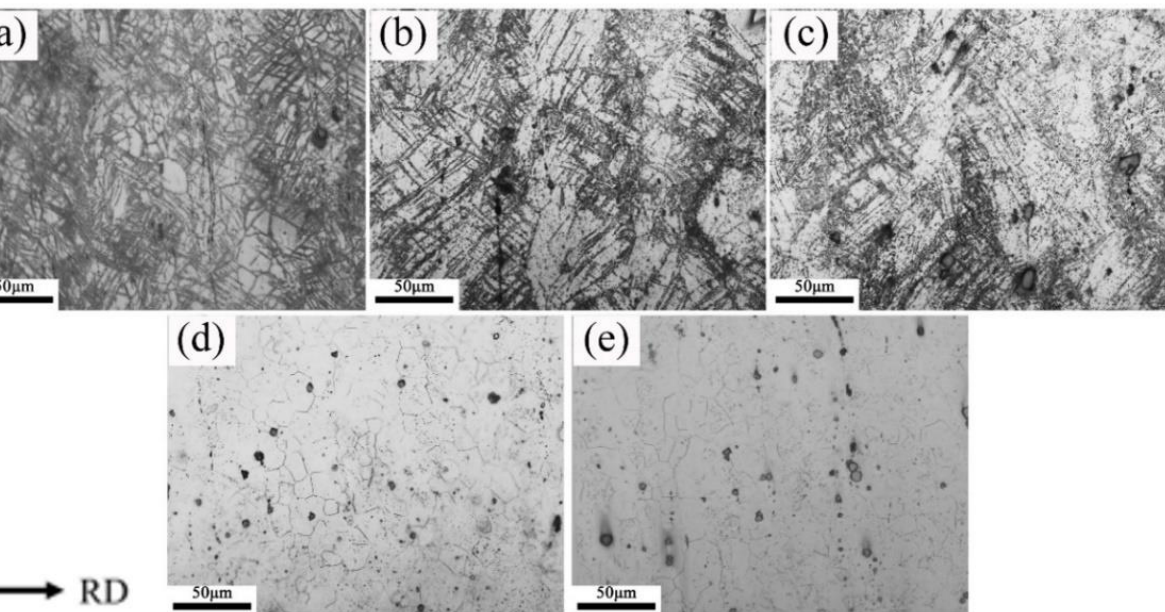
The OM metallographic images of the AZ61-modified rolled sheets are shown in Figure 2. For the AZY0, AZY1 and AZY2 sheets, the deformation grains dominated, which were arranged at an angle of 45 ◦ to the deformation direction (Figure 2a–c). Among them, the AZY0 grains were relatively fine (Figure 2a), and with the increase in Y content, the size of the grains further decreased (Figure 2b,c). When the content of Y was further increased above 0.9 wt.%, there were no longer deformation grains in the AZY3 and AZY4 sheets, but the equiaxed crystals were the main structure, and the number of precipitates in AZY3 and AZY4 were also increased significantly.